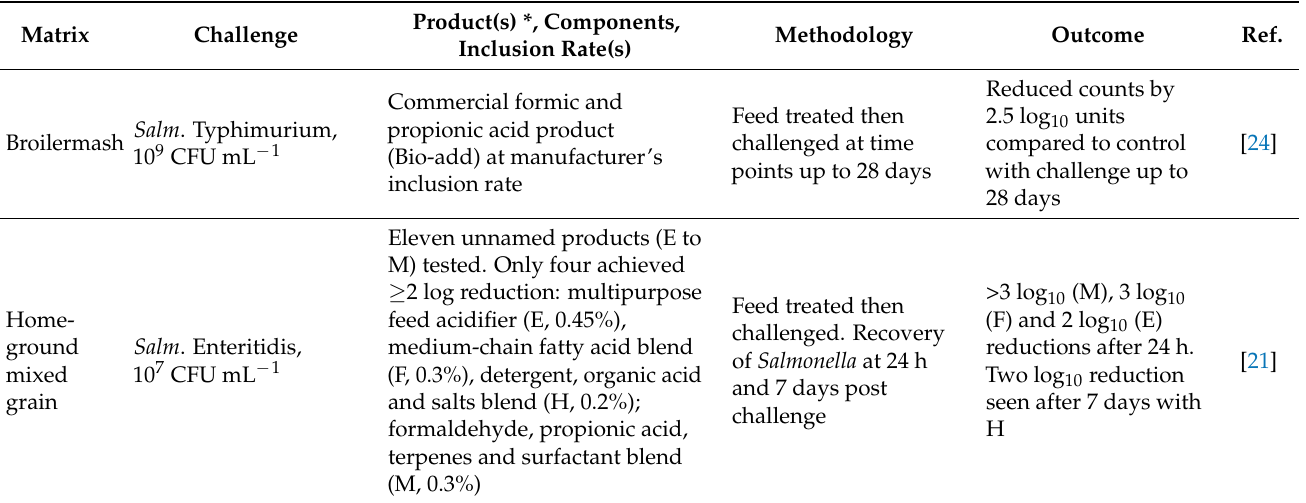
Table 2. Studies on the use of microbicidal additives to prevent Salmonella contamination of feed.